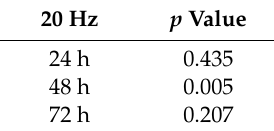
Figure 4. Percentage of viable CT2A cells after exposure to a 100 µ T EMF at 20 Hz, 30 Hz and 50 Hz for 24 h, 48 h and 72 h.